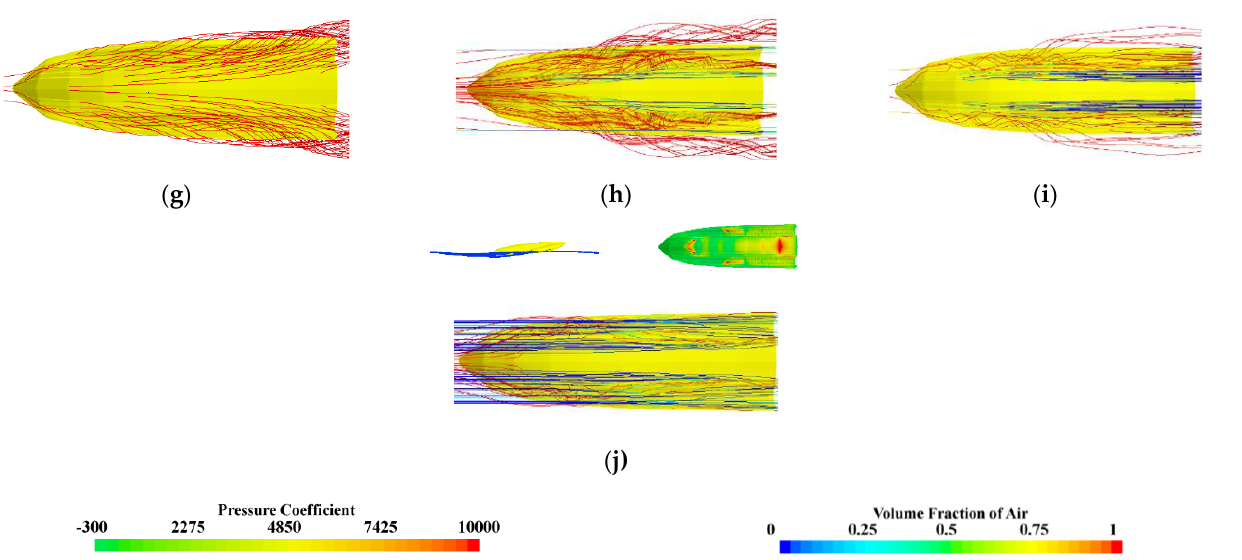
Figure 18. Snapshots of the air and water streamlines around the bottom surface of the Model B. The presented snapshots correspond to the motion of the vessel in wavelengths of 2 L with a beam Froude number of 5.6. The panels respectively refer to the data that were sampled at ( a ) t = T /10, ( b ) t = 2 T /10, ( c ) t = 3 T /10, ( d ) t = 4 T /10, ( e ) t = 5 T /10, ( f ) t = 6 T /10, ( g ) t = 7 T /10, ( h ) t = 8 T /10, ( i ) t = 9 T /10, and ( j ) t = T . Each panel shows the position of the vessel with respect to the water (up on the left side), hydrodynamic pressure distribution over the bottom surface (up on the right side), and the streamlines (down).